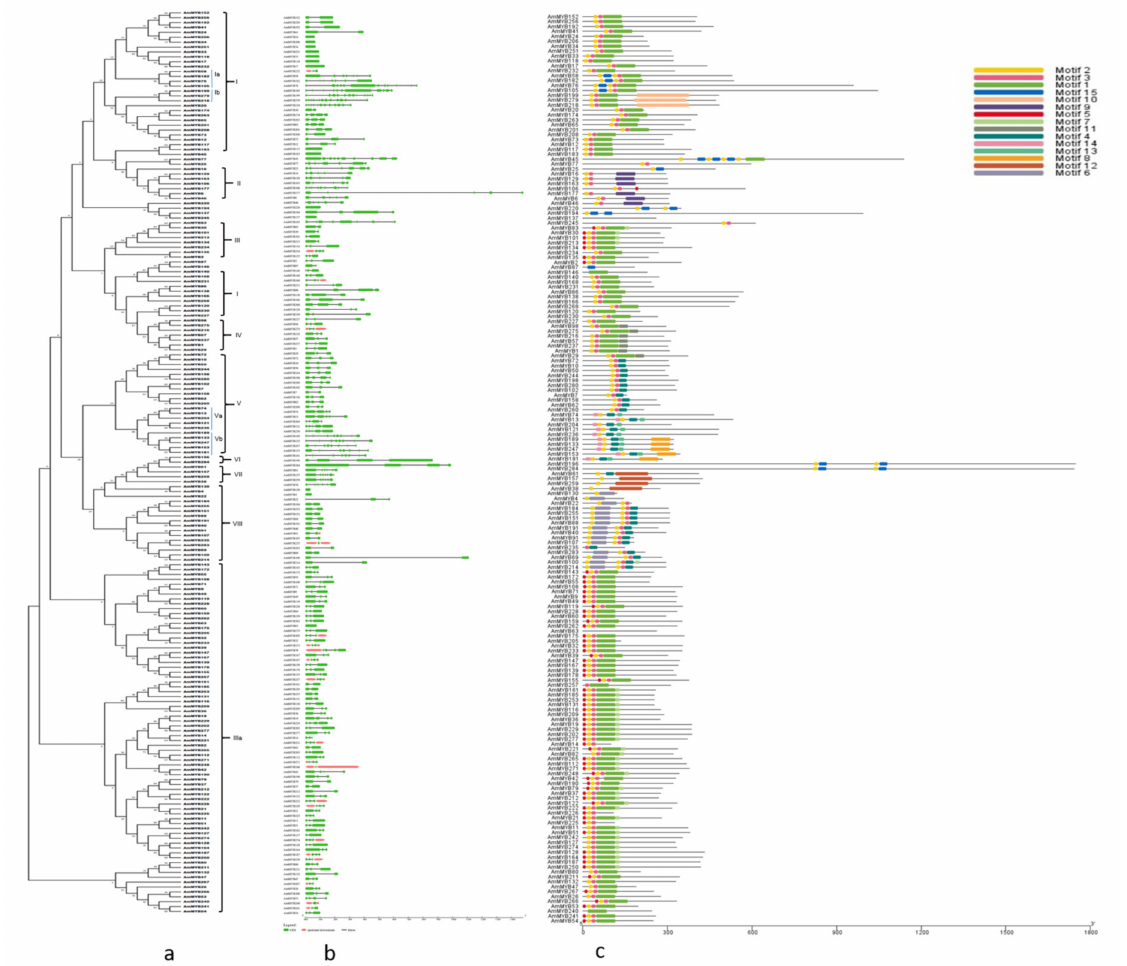
Figure 1. Phylogenetic classification and motif analysis of the AmR2R3 MYB genes. ( a ) The phylogenetic tree was constructed using the MEGA X software with Neighbour-Joining algorithm with 100 bootstraps. The exon-intron structures of genes ( b ) and conserved motifs in protein sequences ( c ) are depicted alongside the relative phylogenetic positions of AmR2R3 MYB